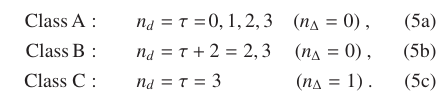
Figure 2. (a) Experimental spectrum and representative E2 rates [2, 6] (in W.u.) of normal [as in Fig. 1(a)] and intruder levels (0 + 2 , 2 + 3 , 4 + 3 , 2 + 4 ) in 110 Cd. (b) U(5)-PDS-CM spectrum, obtained from ˆ H (11) with parameters t 1 = 767 . 8 , t 2 = 2 . 1 , e 0 = 6 . 9 , κ = 72 . 7 , ∆ / 2 = 4989 . 5 , α = 42 . 8 keV and N = 7. The E2 operator (12) used has e ( N ) B = 1 . 96, e ( N + 2) B = 1 . 19 (W . u . ) 1 / 2 − − −